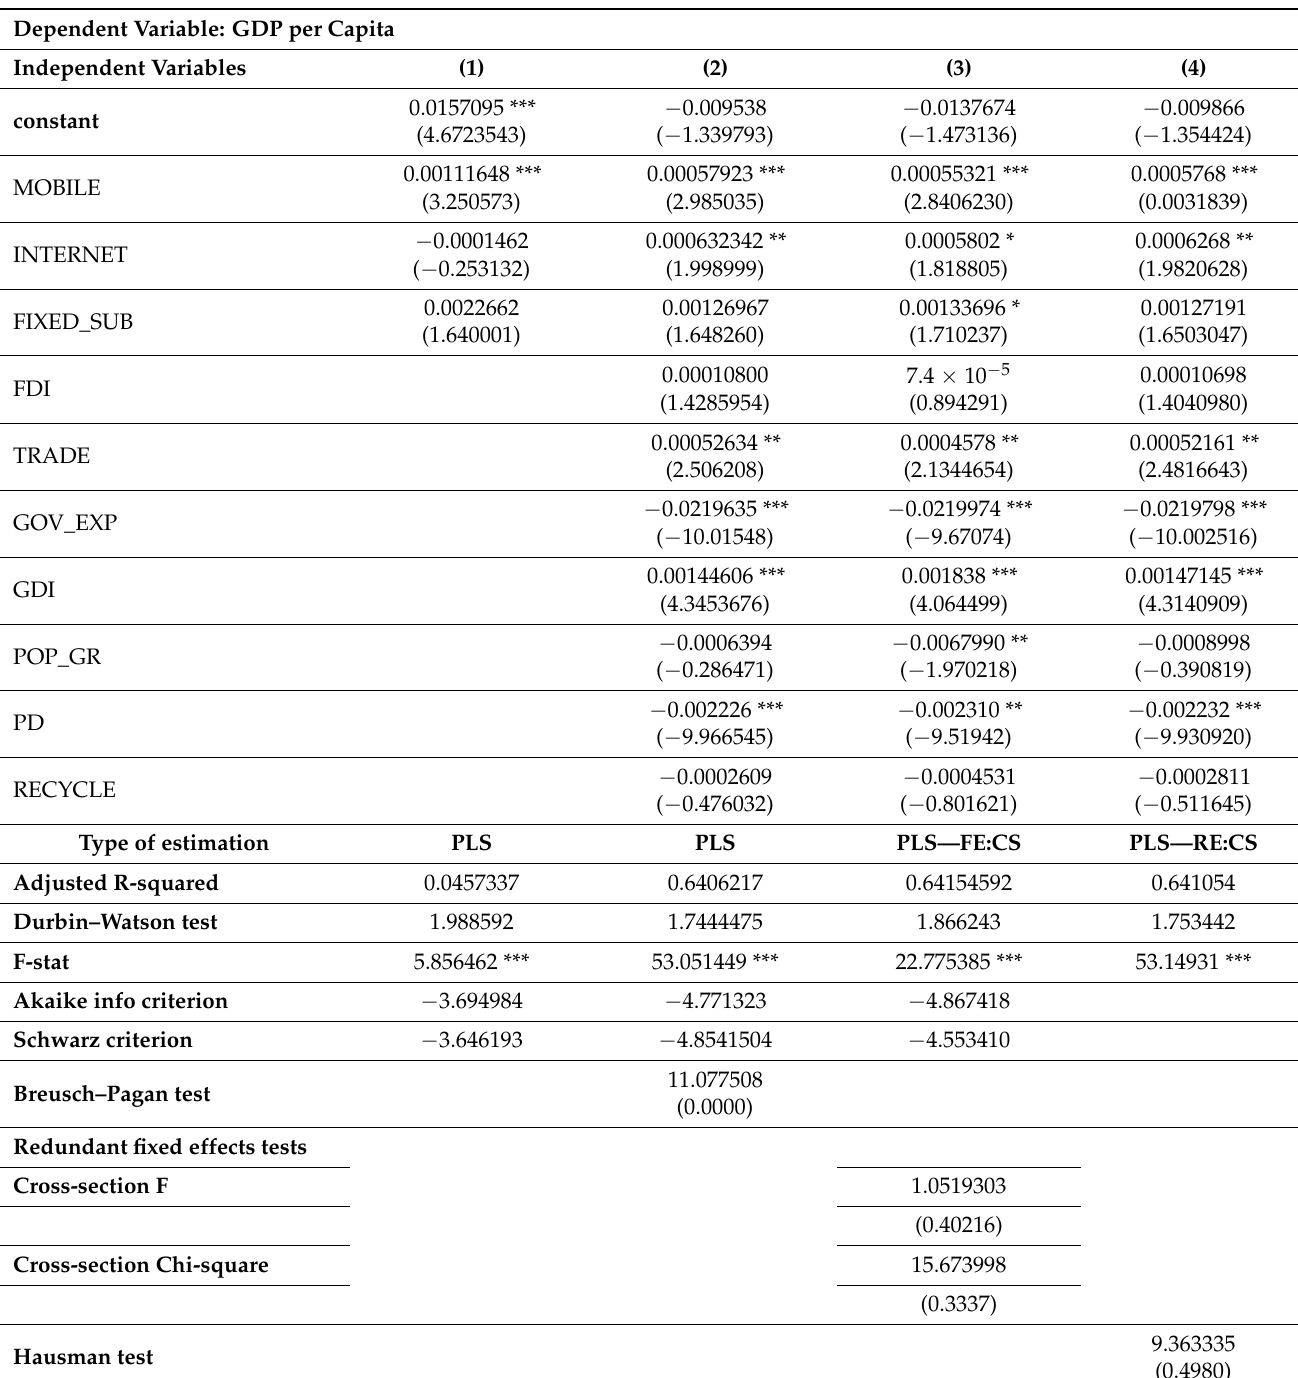
Table 7. Empirical results of panel regressions—EU-15